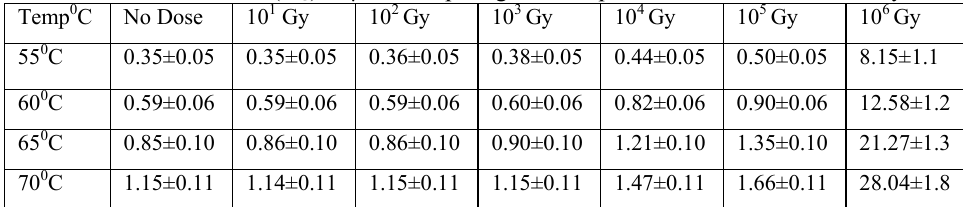
Table 3. Bulk-Etch rate (V ) in µm/h for post-gamma exposed PADC –American Acrylics. G